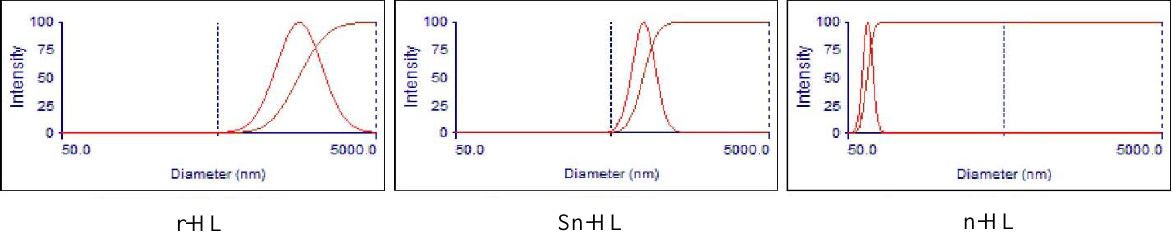
Figure 2. The HL particle size distribution measured by DSL.